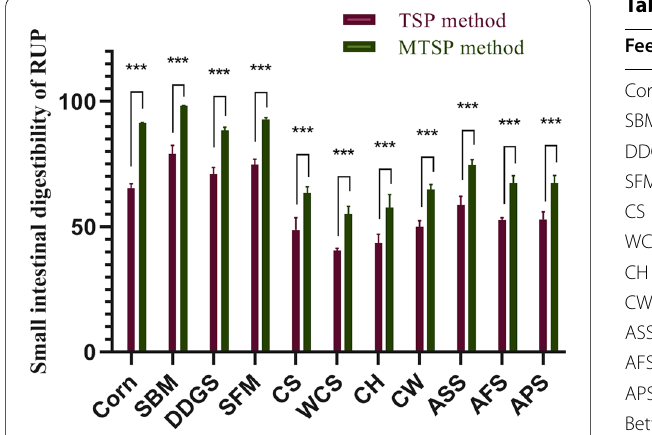
Fig. 1 Sixteen-hour degradation rate of feed ingredients CP in the rumen. SBM, soybean mean; DDGS, distillers dried grains with soluble; SFM, sunflower meal; CS, corn stalk; WCS, whole-plant corn silage; CH, Chinese wildrye; CW, Chinese wildrye; ASS, alfalfa mowed at squaring stage; AFS, full-bloom stage; APS, pod stage